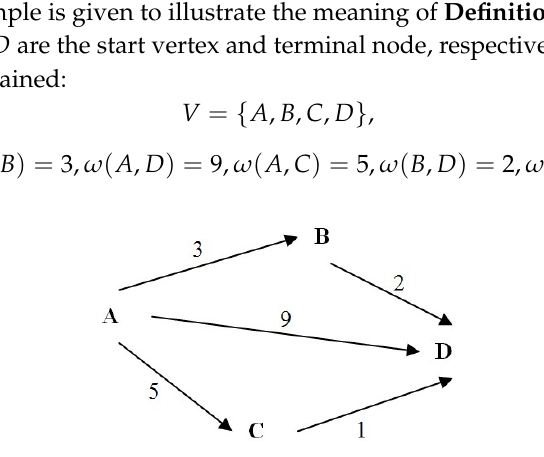
Figure 2. The flowchart of a